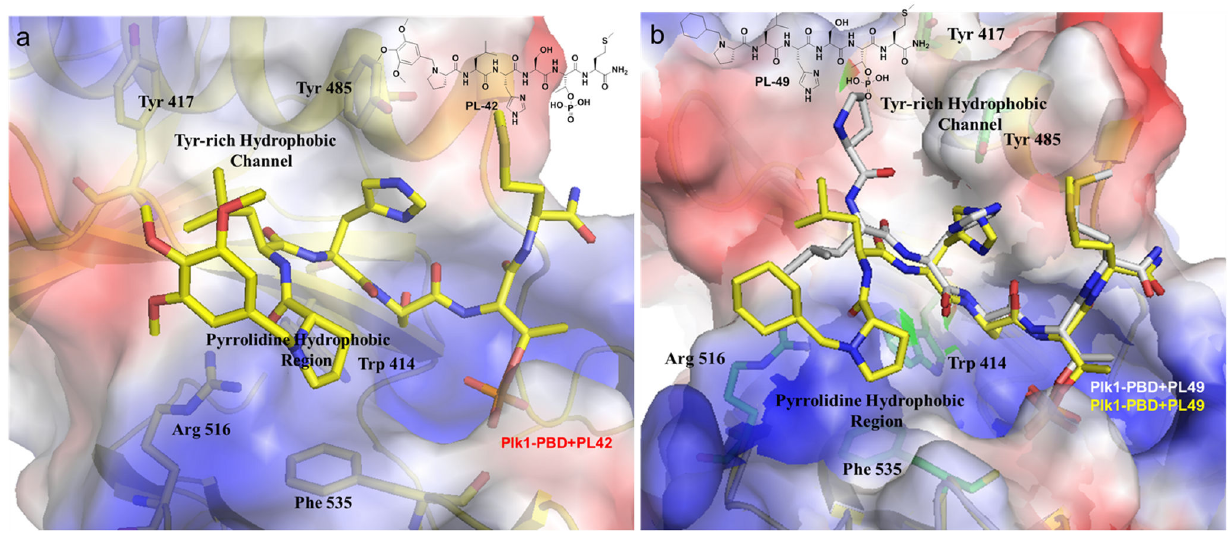
Figure 3. Crystal structures of Plk1 PBD in complex with PL-42 or PL-49. (A) The crystal structure of the Plk1 PBD-PL-42 complex showed that the N- terminal moiety of PL-42 interacts with the pyrrolidine hydrophobic region. (B) The overlay of the two distinct crystal structures of the Plk1 PBD-PL-49 complex revealed that the N- terminal cyclohexyl moiety of PL-49 possesses the dual-binding ability and interacts with either the Tyr-rich hydrophobic channel or the pyrrolidine hydrophobic region. Note that since the N- terminal arm of PL-49 (gray backbone) that points to the Tyr-rich hydrophobic channel could not be localized in the density maps because of its high flexibility, we were not able to model the cyclohexylmethyl segment using PyMOL [19].